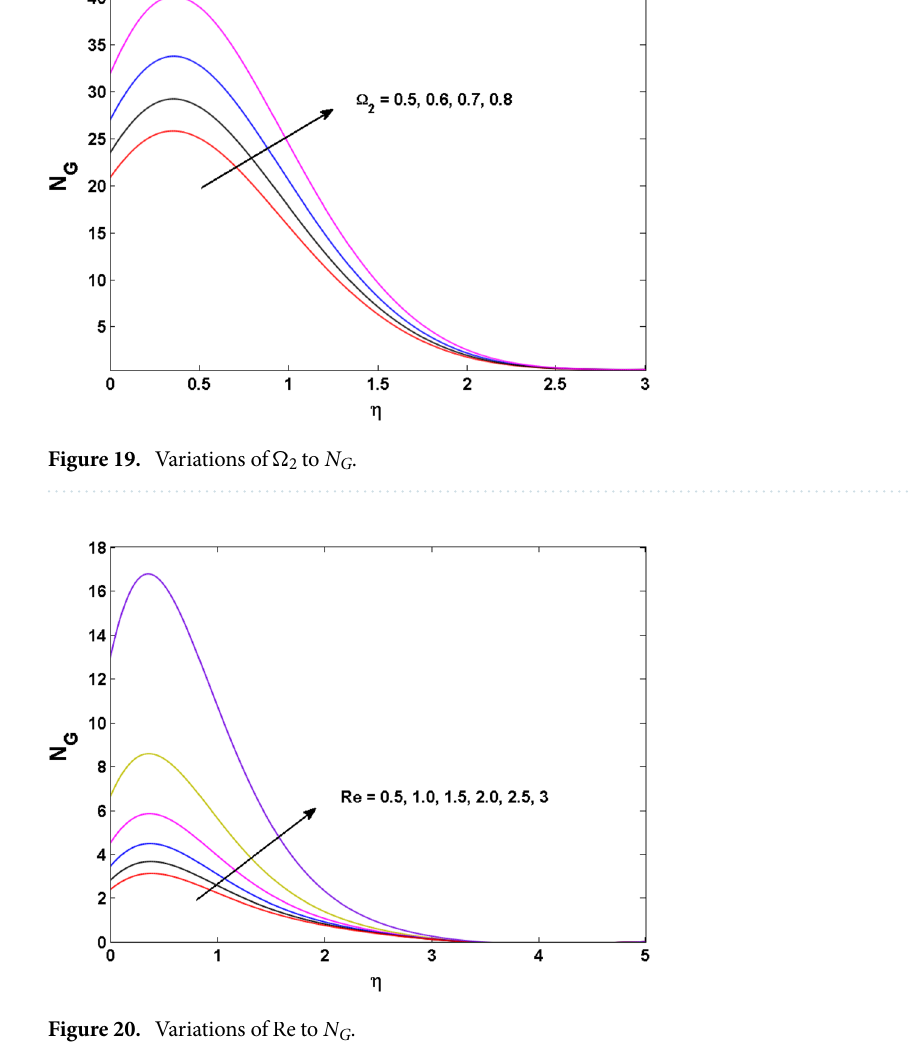
Figure 20. Variations of Re to N G .